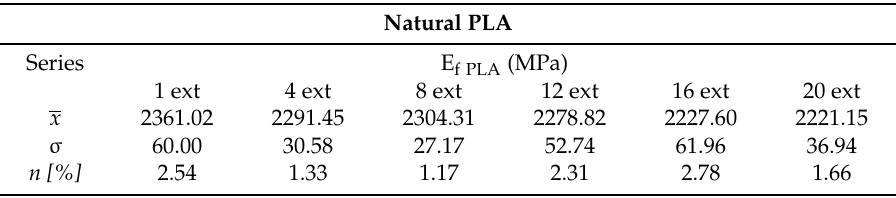
Table 1. Flexural Modulus of the three formulations by each